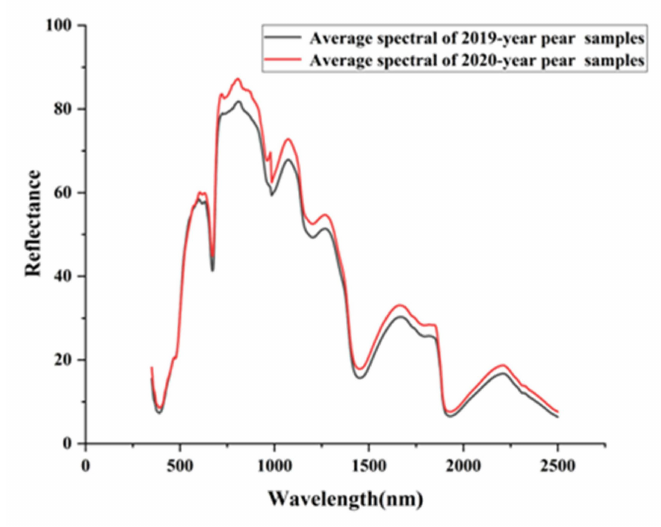
Figure 10. Average spectral profiles of the 2019-year and 2020-year pear samples in the 350–2500 nm range.